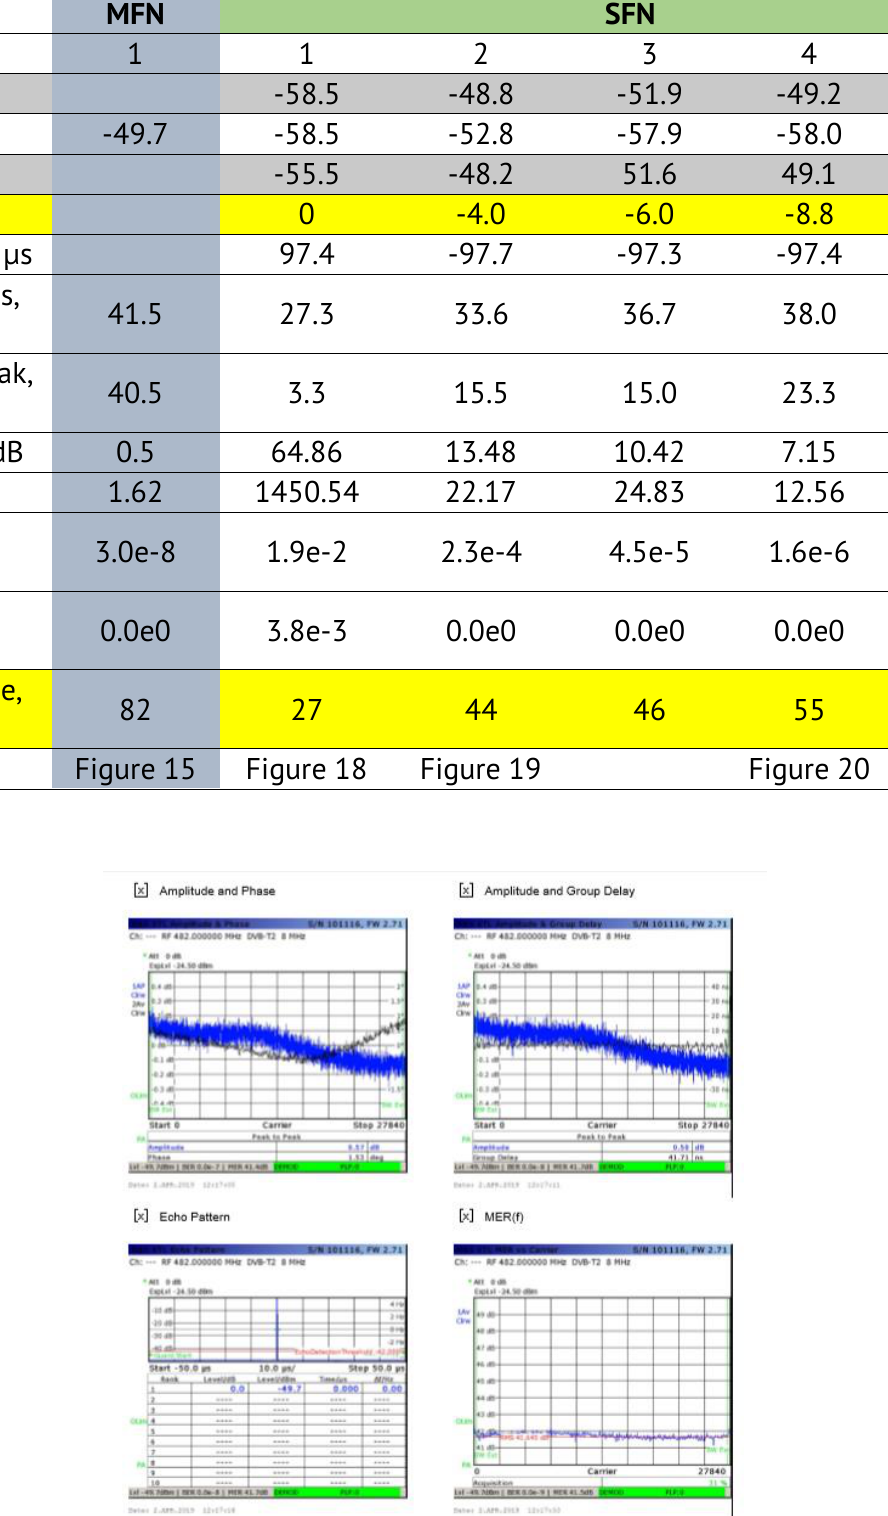
Figure 13. DVB-T2 Signal Form and Values parameters measured in the MFN mode: Level -49.7 dBm; Amplitude 0,57 dB; Phase 1.53 deg; Group Delay, MER(f); MER (PLP, rms) 41.7